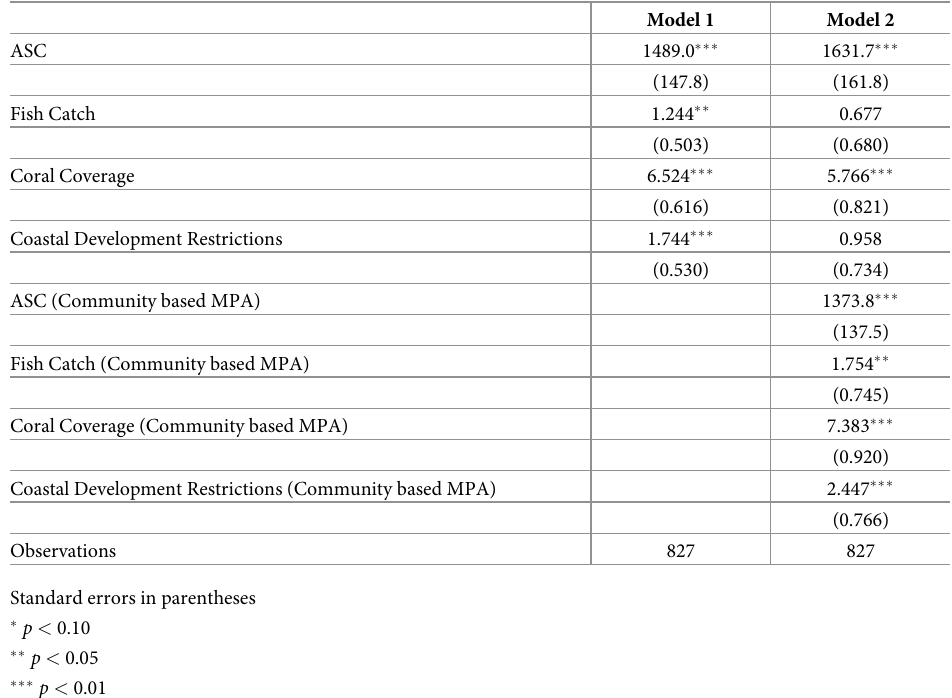
Table 4. Valuation of the selected marine management